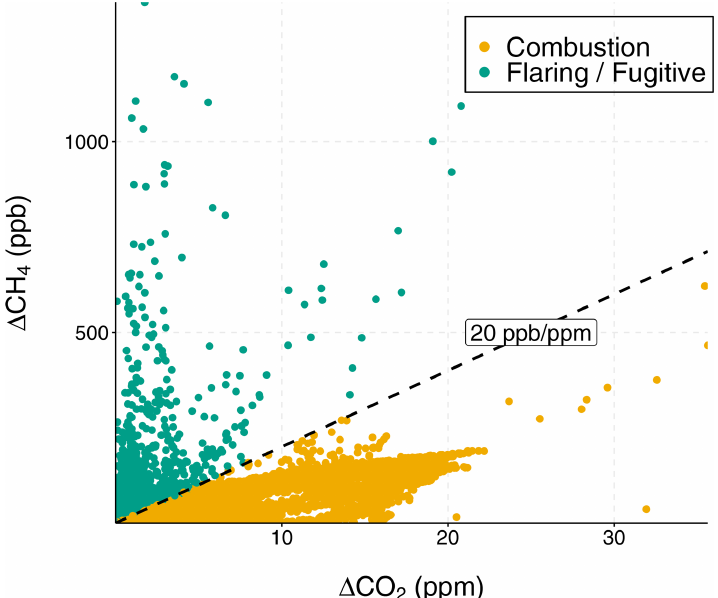
Figure A3. Scatter plot of (cid:49) CH 4 versus (cid:49) CO 2 . The dashed line shows an emission ratio of 20ppbppm − 1 , which was used for filtering data to remove the influence of anthropogenic emissions.